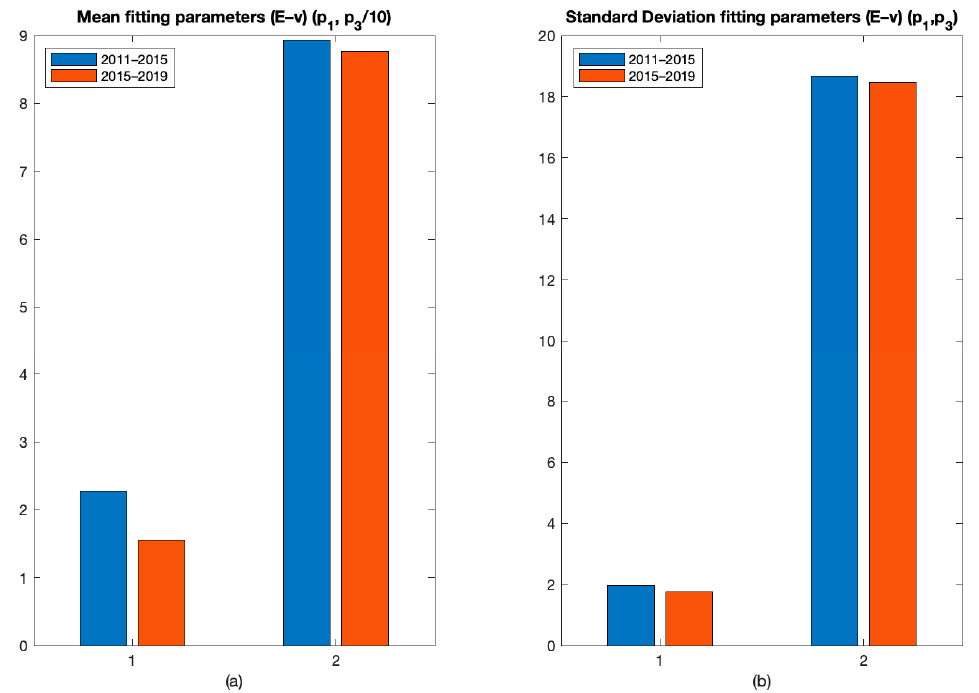
( a ) parameters of the mean model; ( b ) parameters of the standard deviation model.